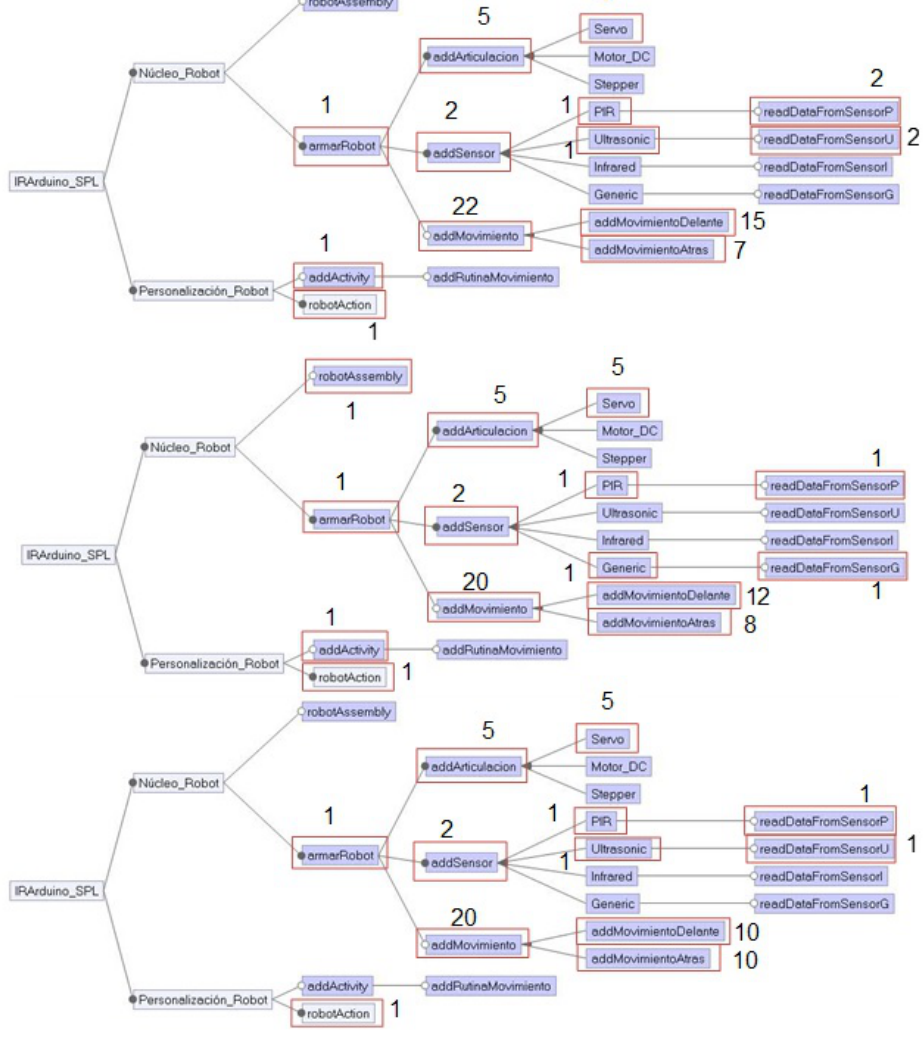
Figure 9. Features used by each of the groups in the execution of the case study for